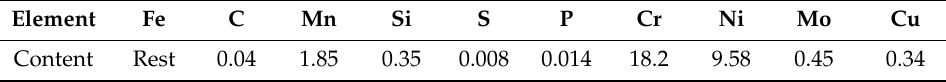
Figure 1. ( a ) Overview of wire arc additive manufacturing equipment; ( b ) schematic diagram of wire arc additive manufacturing process. Table 1. Actual chemical composition used in this experiment (wt.%).